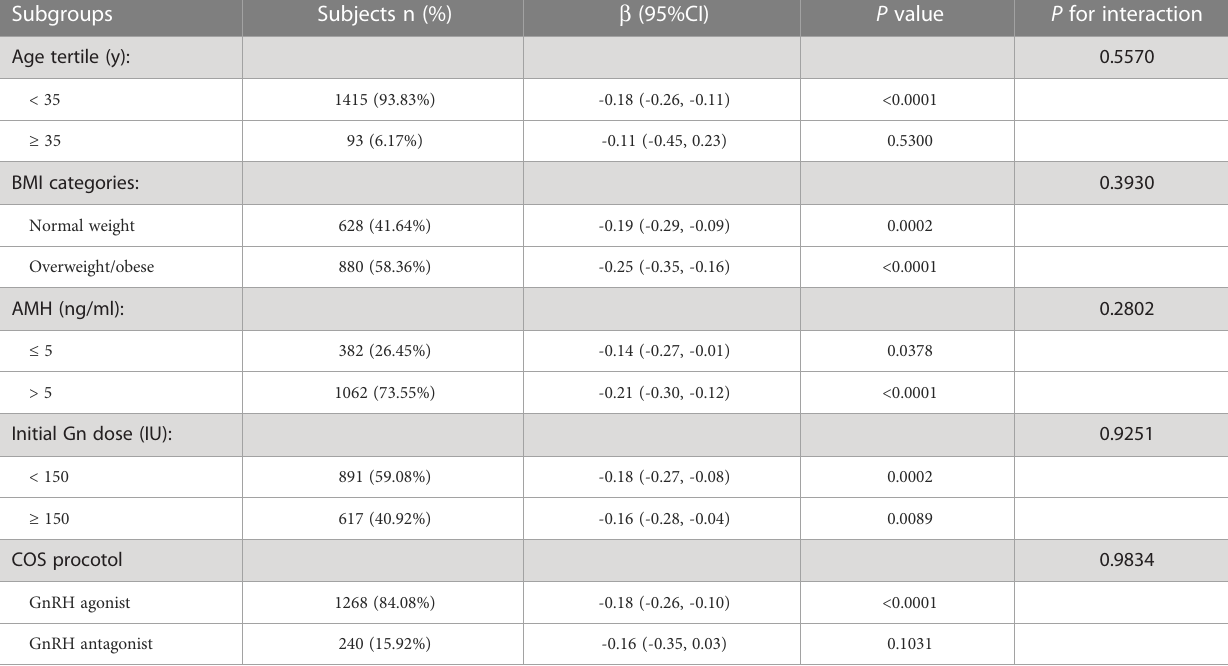
TABLE 3 Subgroup analysis of the association between Ln HOMA-IR and Ln